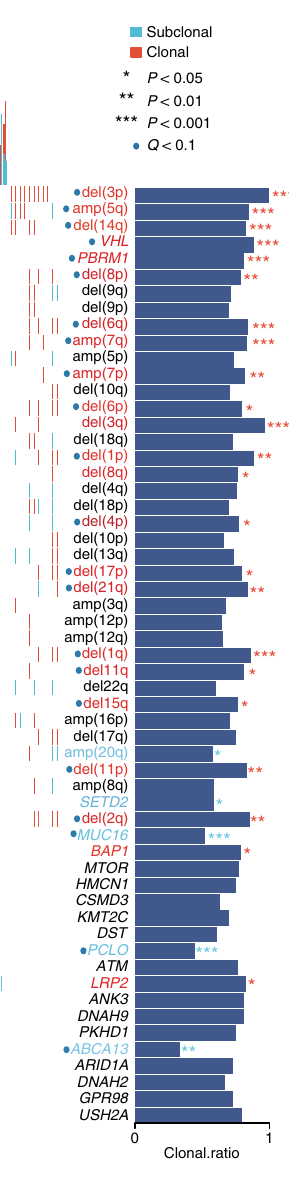
Fig. 2 The clonality of frequently altered genes and arm-level SCNAs in ccRCC. The top panel shows the prevalence of clonal (red) and subclonal (blue) SNVs in the Japanese and TCGA ccRCC cohorts. The bottom panel shows the clonal or subclonal state of each somatic event (row) in all patients. The names of genes and SCNAs signi fi cantly enriched with clonal or subclonal alterations are labeled in red and blue,